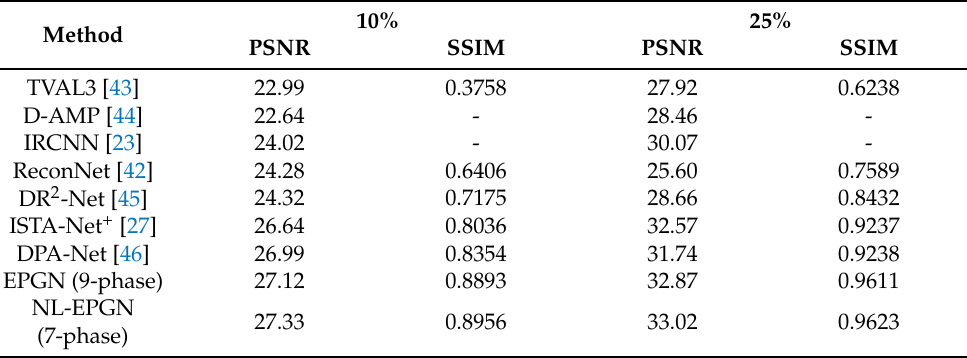
Figure 4. Average PSNR comparison between ISTA-Net + , EPGN and NL-EPGN with various phase number on image compressive sensing problem on Set11 with a CS ratio of 25%. Table 1. Natural image CS reconstruction results by existing methods and the proposed EPGN (with 9 phases) and NL-EPGE (with 7 phases) on dataset Set11 with CS ratios of 10% and 25%. Table shows the average PSNR (dB) of the comparison